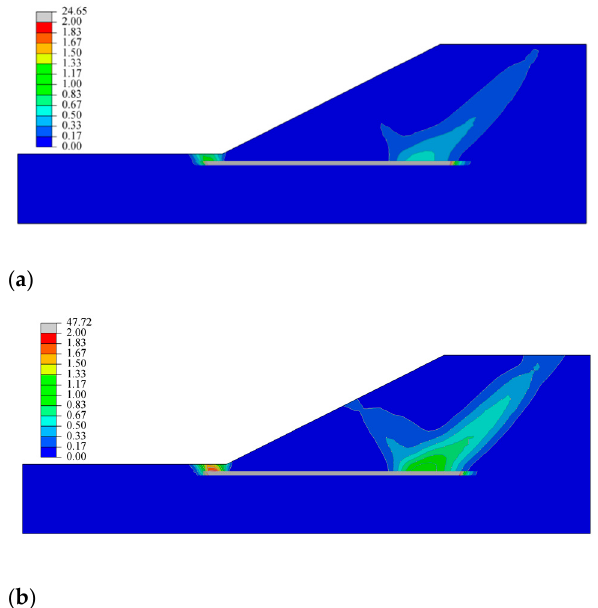
Figure 11. Mesh for Example 2.